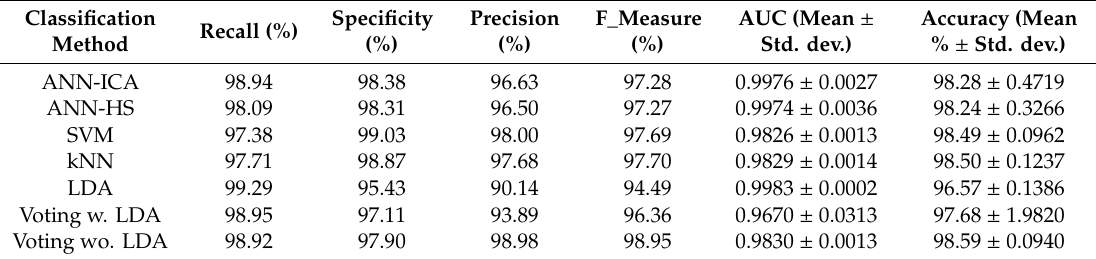
Table 7. Performance evaluation criteria of the classifiers and the 275 executions.